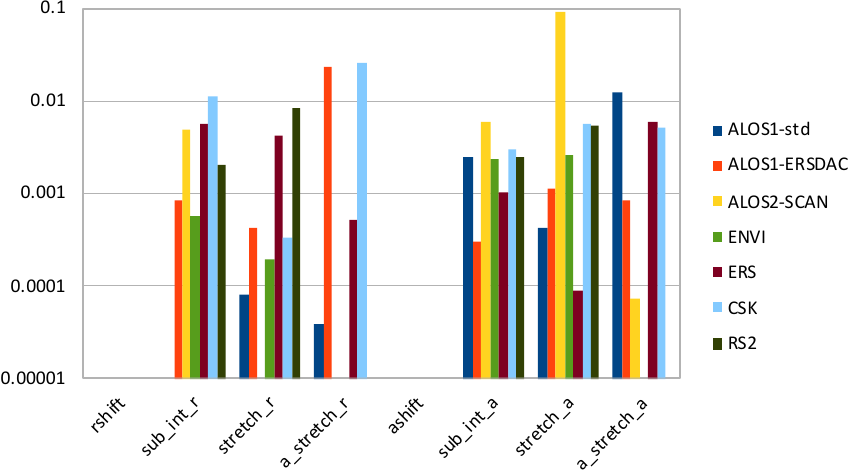
Figure 8. Histogram of relative error (in logarithmic scale) on output values from fitoffset.csh , when cross-correlation is calculated with xcorr2-cl